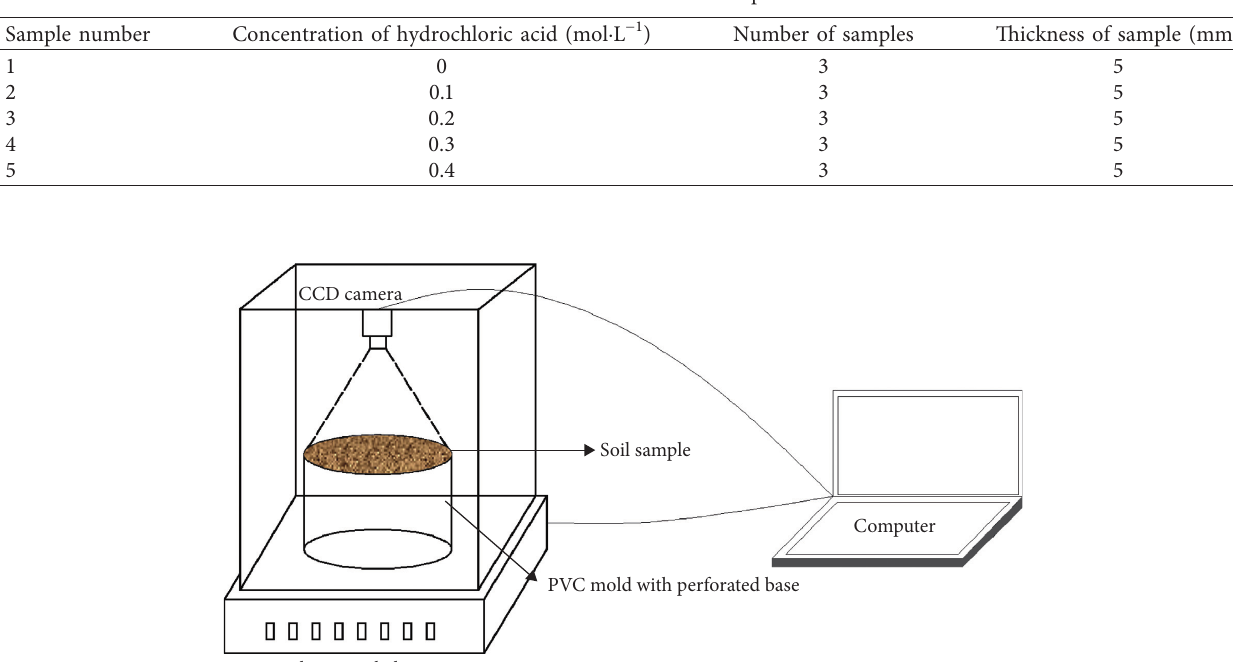
Table 2: Parameters of soil samples.